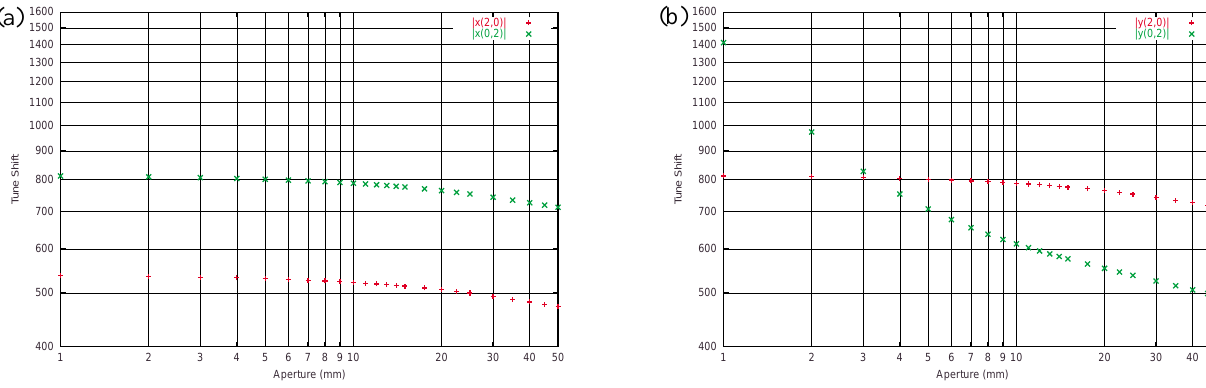
FIG. 9. (Color) Second-order amplitude dependent tune shifts as a function of aperture in log-log scale: (a) x tune shifts and (b) y tune shifts. The maximum slope is around 1.